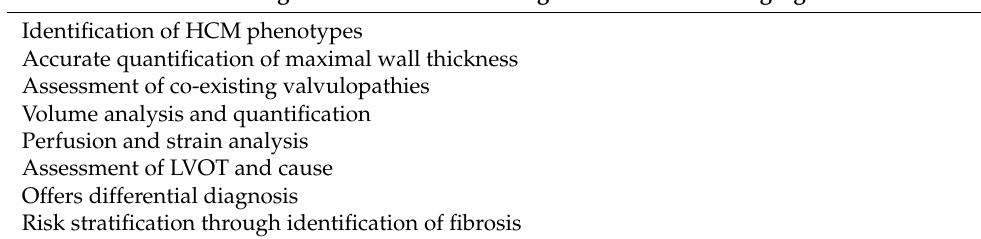
Table 1. There are several advantages of cardiovascular magnetic resonance imaging (CMR) that include functional evaluation, morphological visualization, and risk stratification. There is also the added benefit of differentiating HCM from other similar processes that result in cardiac hypertrophy, such as amyloidosis, athlete’s heart, and hypertensive heart